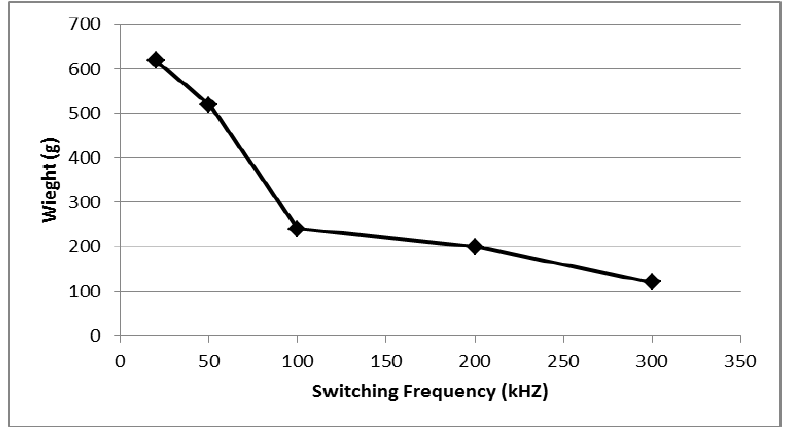
Figure 14. The effect of increasing the switching frequency on the inductor